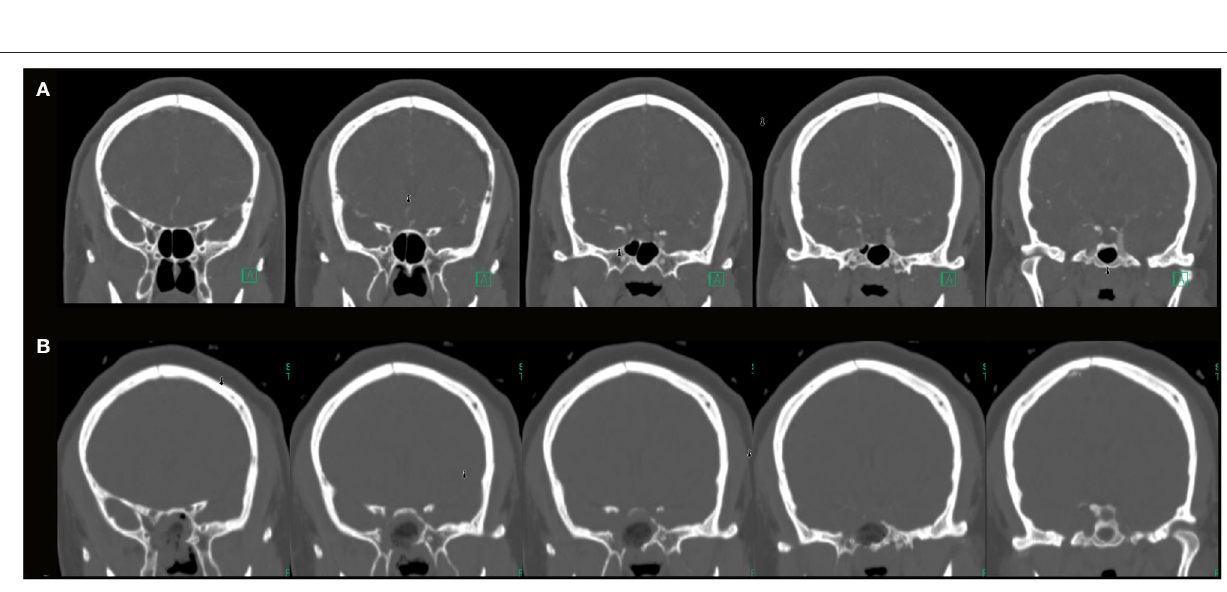
Frontiers in Neurology |